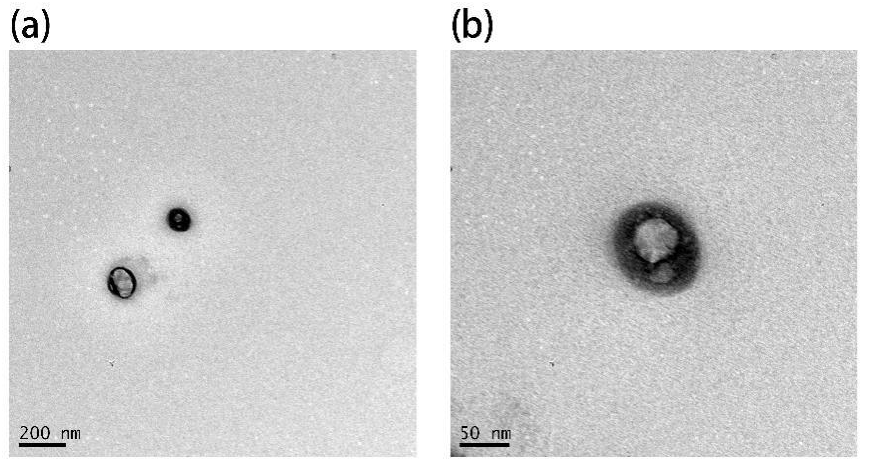
Figure 9. TEM image of Ag-UCNPs@SiO 2 , ( a ): the scale of 200 nm, ( b ): the scale of 50 nm. Modified rare-earth nanomaterials were dispersed in normal saline to prepare different concentrations after which HeLa cells were cultured for 4 h and their activity was tested (Figure 10). When the concentration is <400 µ g/mL, the cell survival rate is >89%. In particular, at 200 µ g/mL, the cell survival rate was >99%. Combined with Figure 5, the luminescence intensity of rare earth, 200 µ g/mL concentration of rare-earth nanomaterials not only have sufficient safety but also have a high luminous intensity. When the rare-earth ion concentration is as high as 500 or even 600 µ g/mL, the cell survival rate is still